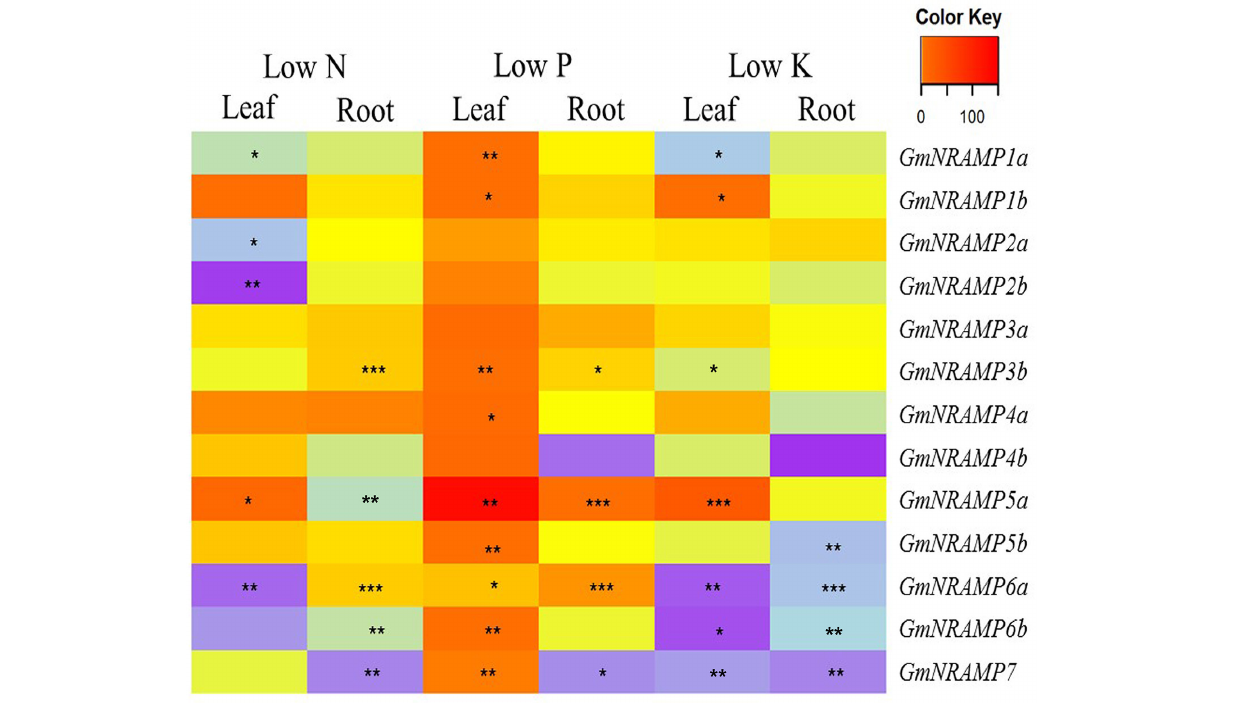
FIGURE 5 | Expression profiles of GmNRAMP genes under nitrogen, phosphorus or potassium deficiency conditions. Ten-day-old soybean seedlings were subjected to nitrogen (LN), phosphorous (LP), or potassium (LK) deficiency conditions for 14 days, during which time obvious nutrient deficiency symptoms developed. Leaves and roots were separately harvested for qRT-PCR analysis. Fold-changes of GmNRAMP gene expression were normalized against the reference gene TefS1 using 2 − 1 Ct values. Differential expression was determined for four biological replicates in FDR adjusted t -tests of 2 − 1 Ct values from nutrient deficient tissues vs. corresponding control tissues. The heat map displays 2 − 11 Ct values to show relative expression of nutrient deficient samples vs. controls, with significant differences between treatment and control marked as follows, *0.01 < P < 0.05, **0.001 < P < 0.01, *** P <